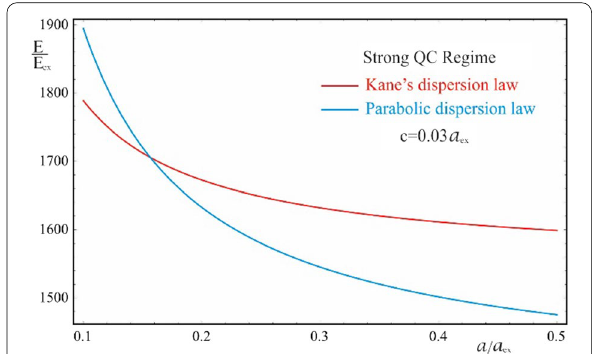
Fig. 4 The dependence of the ground state energy on the major semiaxis a at the fixed value of the minor semiaxis c for the Kane’s and parabolic dispersion laws of CCs